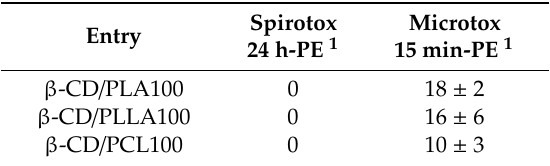
Table 3. The toxicity results of the Spirotox and Microtox assays for the synthesized branched polyesters’ extracts (1.0 mg /